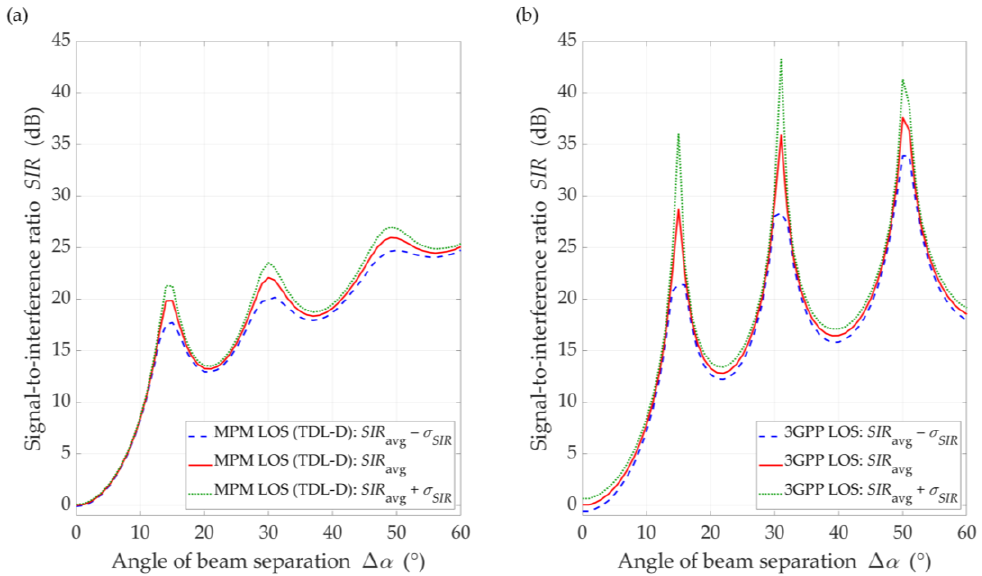
Figure 14. SIR comparison between ( a ) MPM and ( b ) 3GPP model for DL scenario, D = 100 m, and LOS conditions.